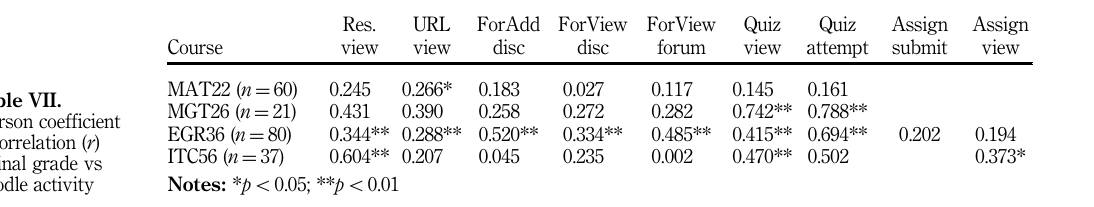
Table VII. Pearson coefficient of correlation ( r ) of final grade vs Moodle